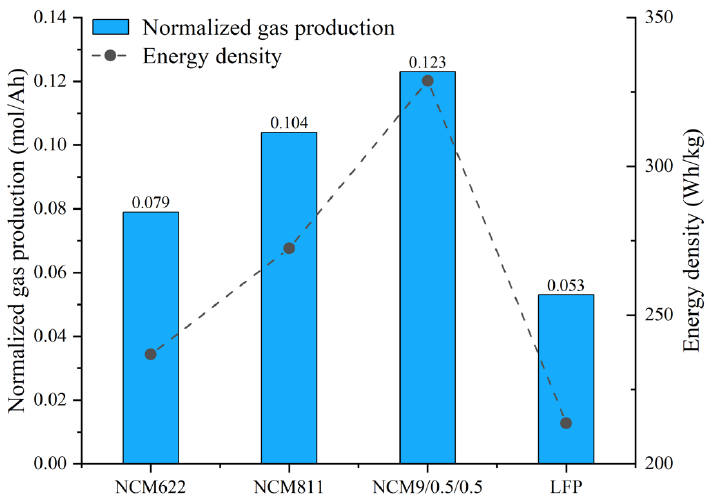
Figure 9. Normalization results of gas production.